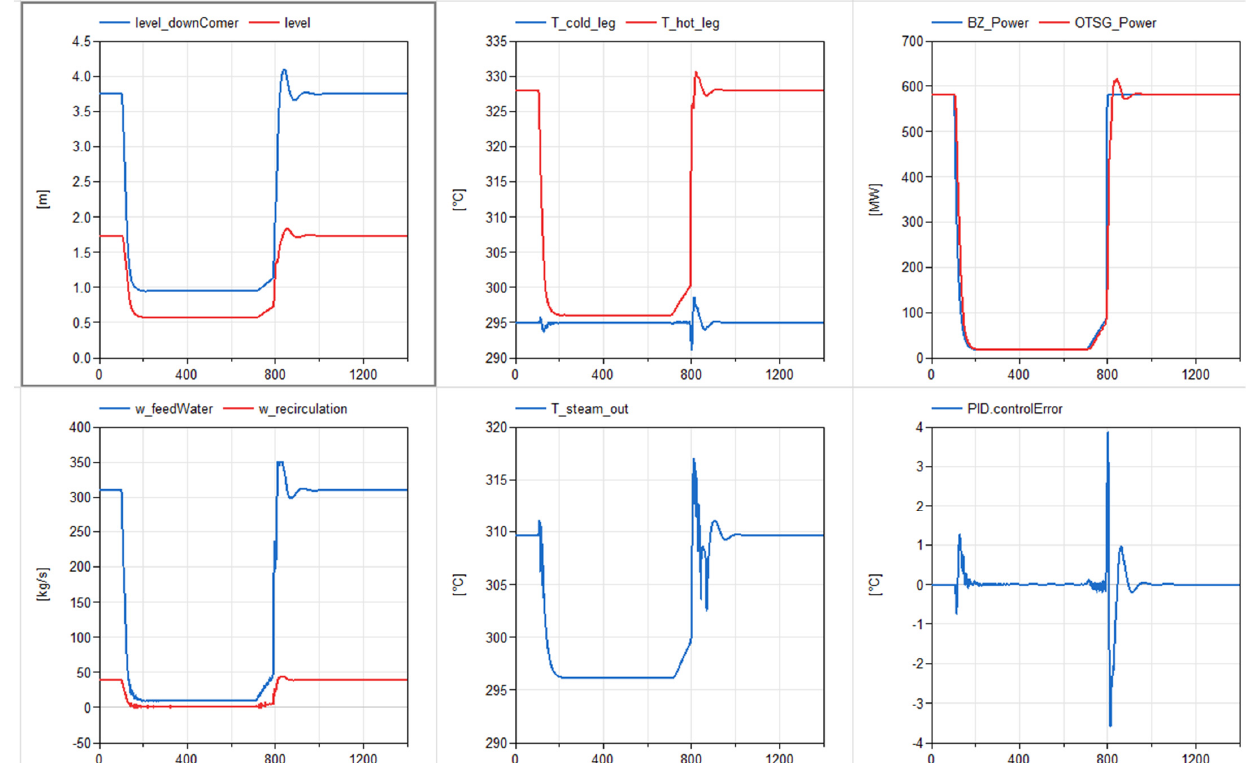
Figure 4. Simulation results for control logics 2 during pulse–dwell–pulse transitions. Pulse->dwell starts at 100 s, dwell->pulse starts at 700 s.